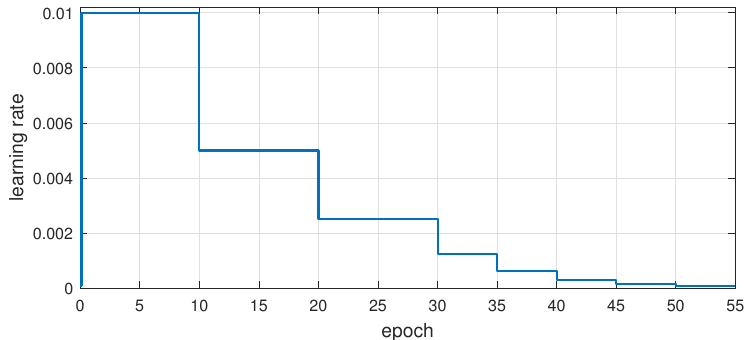
Figure 7. Learning rate adjustment during